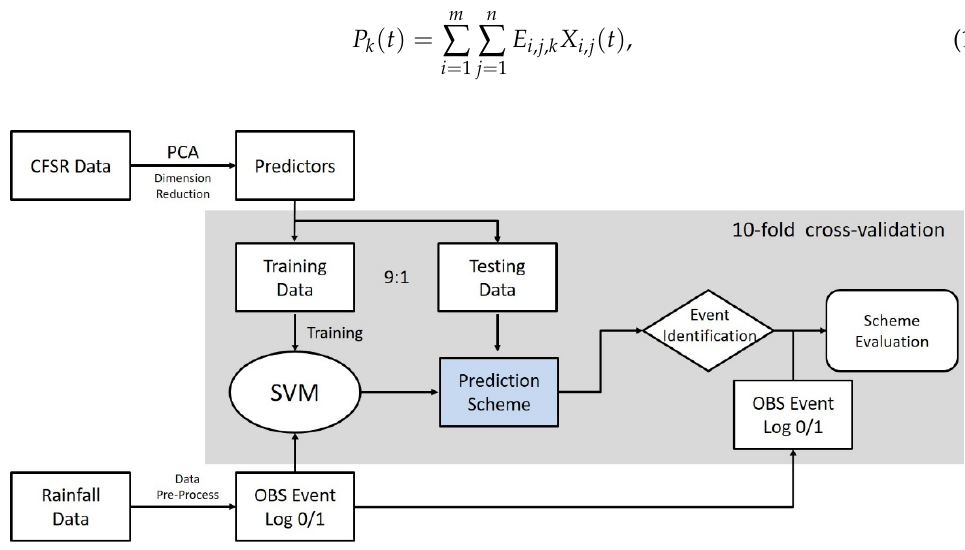
Figure 2. The schematic diagram for constructing the SVM-based prediction